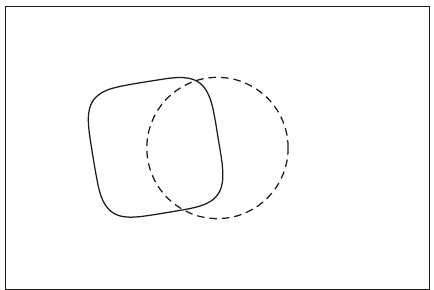
Figure 11: Shapes of Model 2 before and after